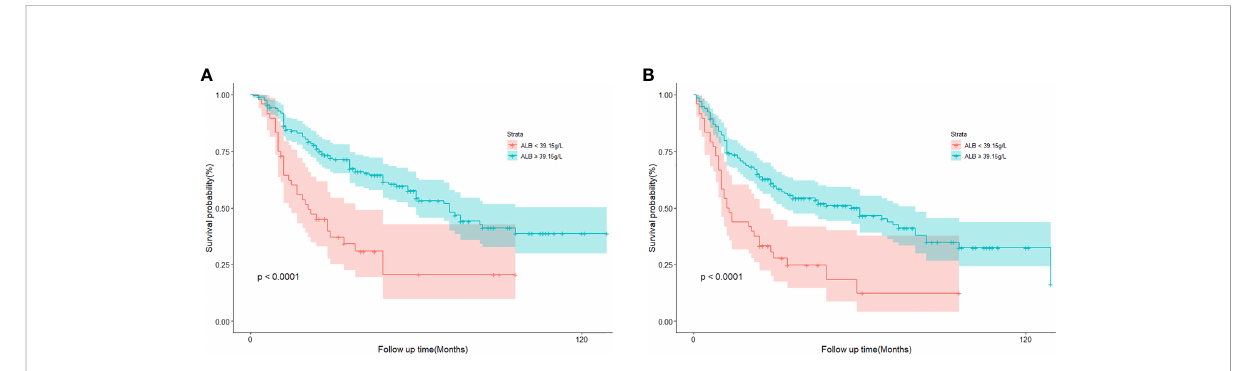
FIGURE 2 (A) Kaplan-Meier curve of cumulative overall survival in 246 patients with oropharyngeal cancer according to albumin levels classi fi cation. (B) Kaplan-Meier curve of cumulative disease-free survival in 246 patients with oropharyngeal cancer according to albumin levels classi fi cation.